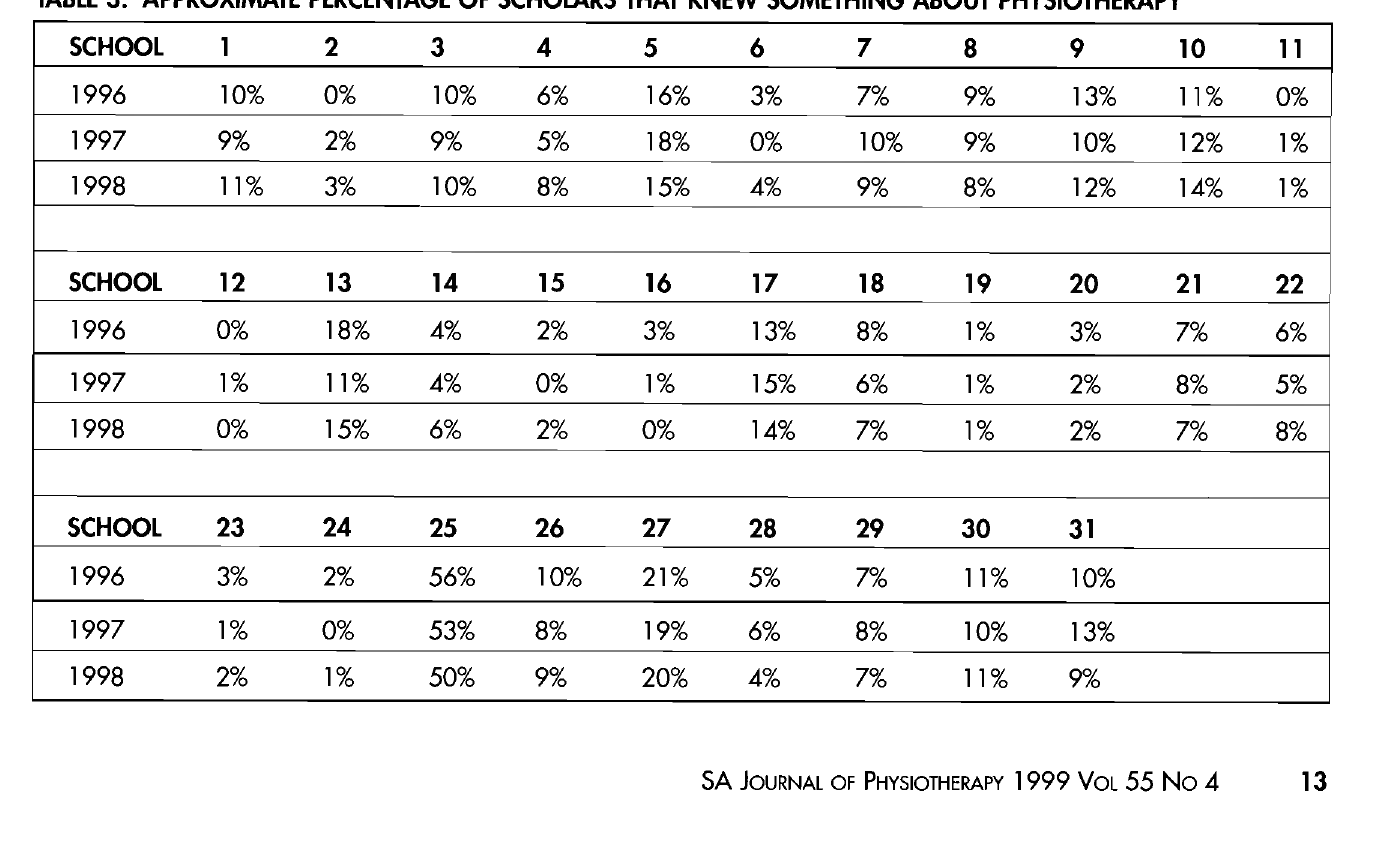
TABLE 3: APPROXIMATE PERCENTAGE OF SCHOLARS THAT KNEW SOMETHING ABOUT PHYSIOTHERAPY